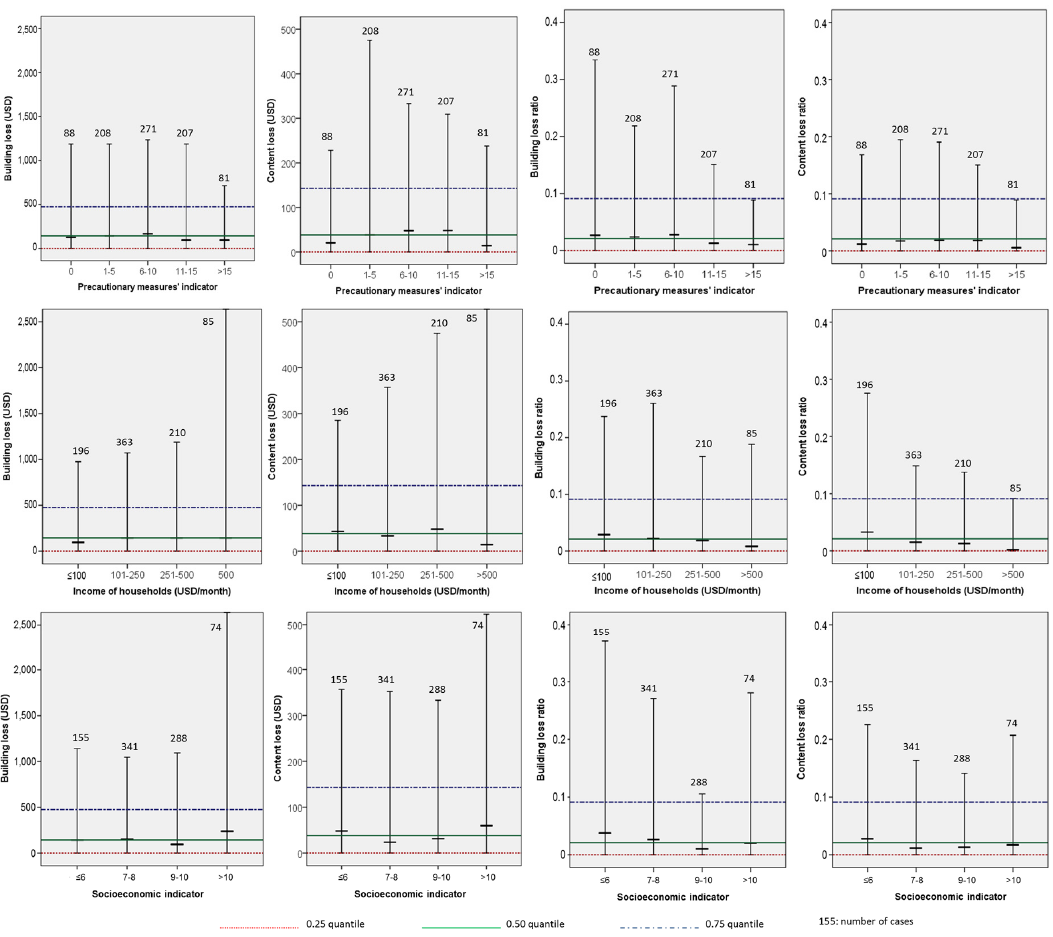
Figure 6. The relation between the building loss ratio and the content loss ration with the precautionary measure indicator, socioeconomic status and income.